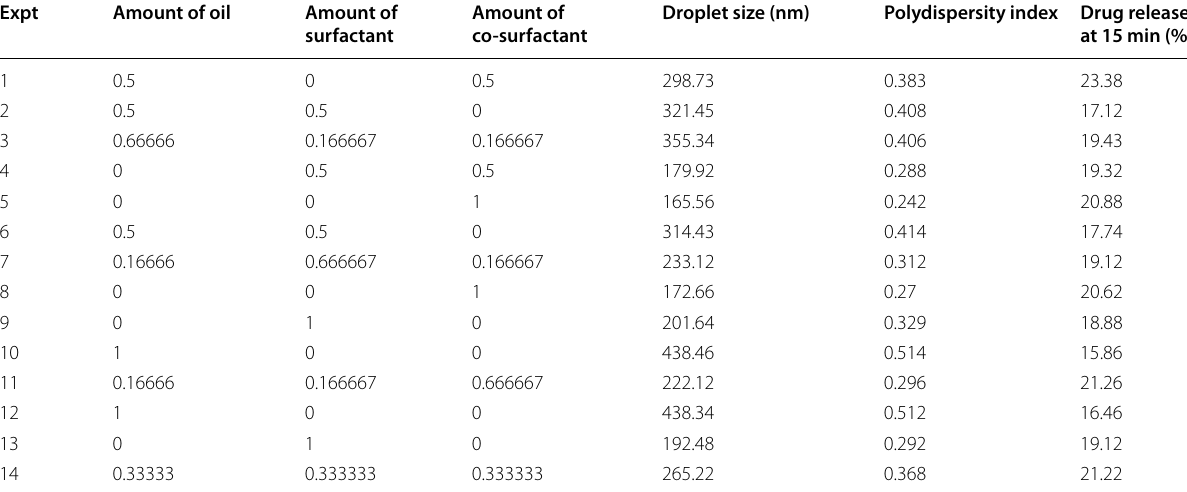
Table 1 The experimental composition and results of simplex-lattice design Expt Amount of oil Amount of